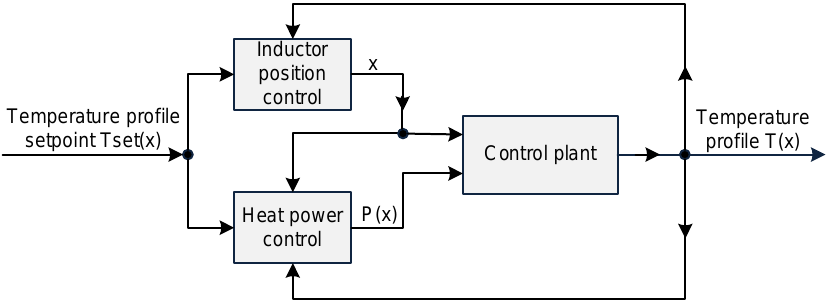
Figure 13. Block diagram of a two-circuit temperature control system, where x — position along the the forming cylinder, Tset(x)—temperature profile setpoint, T(x)—temperature profile, P(x)—heat forming cylinder, Tset(x) — temperature profile setpoint, T(x) — temperature profile, P(x) — heat power power profile.